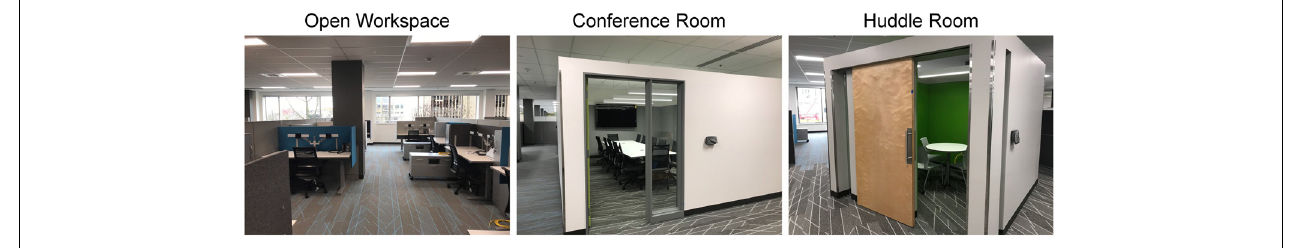
FIGURE 4 | Different types of rooms of the retrofitted workspace. TABLE 2 | Average PM concentration levels pre- and post-retrofit during normal and smoke days (for working hours on weekdays). Outdoor